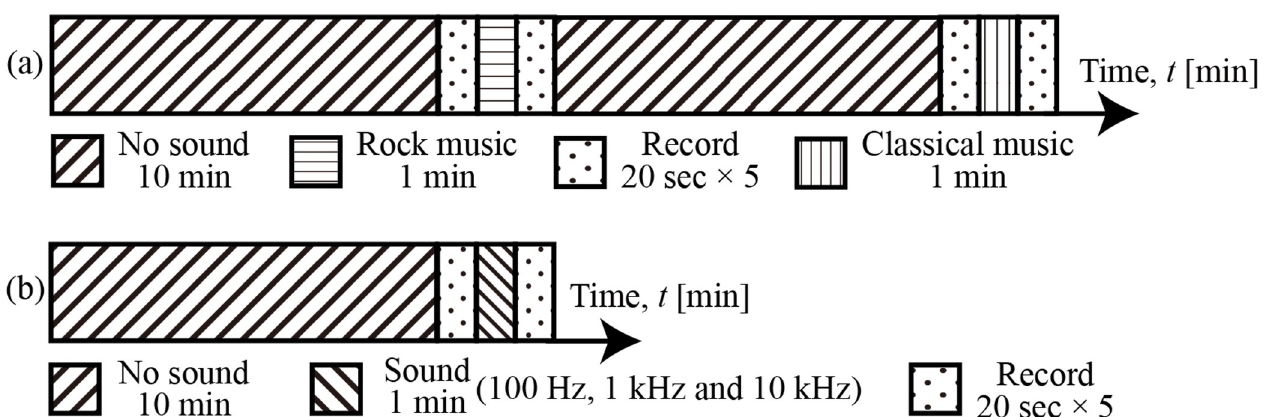
Fig 3. Protocol showing two cycles with each cycle starting with a blank period indicated by the slanted hatch followed by recording of biospeckles for 20 sec which is followed by a minute exposure to (a) music rock or classic and (b) frequencies 100Hz, 1KHz and 10kHz. Here both the rock and classic music and the frequencies were given